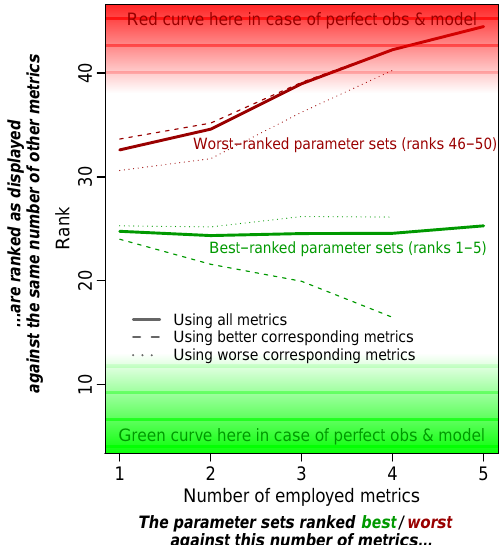
Worst−ranked parameter sets (ranks 46−50)